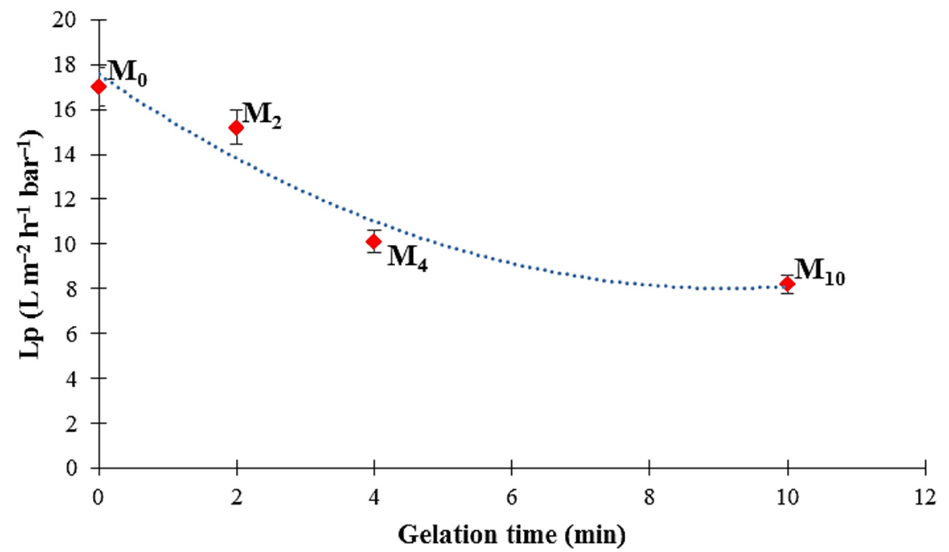
Figure 11. Membrane hydrodynamic permeability of the PA6 membranes as a function of the gelation time.